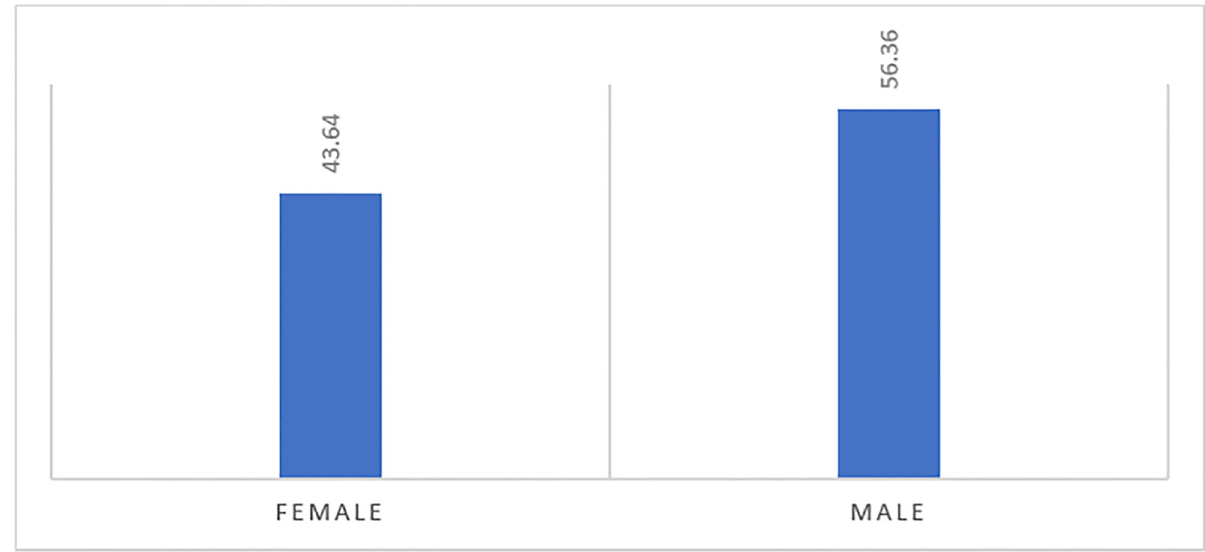
Fig 3. Percent of No VR uptake, by MCHS provider gender (P = 0.003).